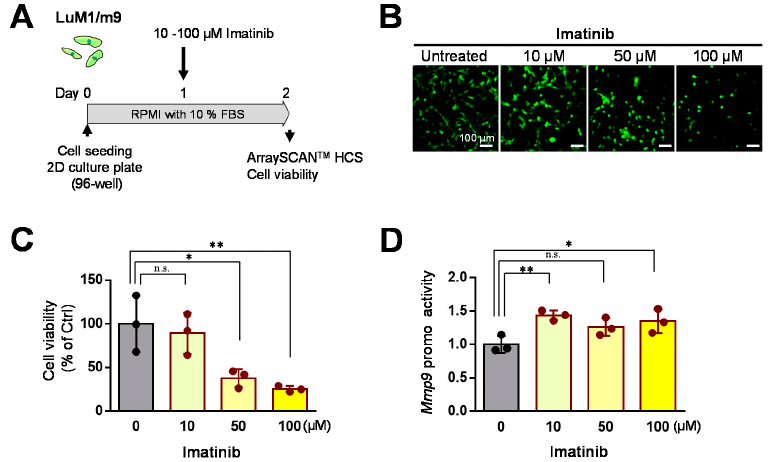
Figure 5. Effects of Imatinib on LuM1/m9 cells in the 2D culture system: ( A ) a scheme of the experimental protocol. Cells were treated with 10, 50, or 100 µ M Imatinib or untreated; ( B ) representative fluorescence images of LuM1/m9 cells; ( C ) Mmp9 promoter activities. n = 3 independent culture wells; ( D ) cell viability. n = 3 independent culture wells. * p < 0.05, ** p < 0.01. n.s., not significant.